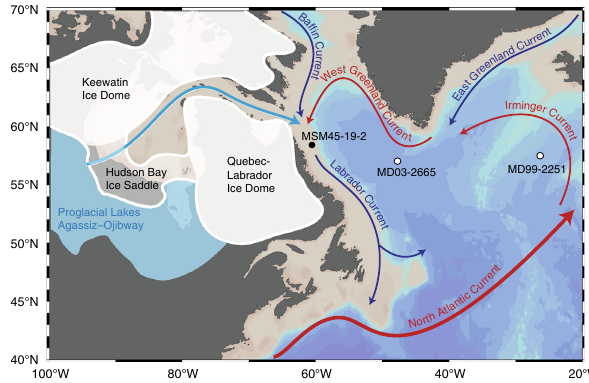
Fig. 1 North Atlantic Ocean circulation and sediment core locations. The white shaded area shows the extent of the Laurentide Ice Sheet (LIS) at 8.5 ka before present, with the Hudson Bay Ice Saddle connecting the Keewatin and Quebec-Labrador Ice Domes 32 – 34 . The blue shaded area displays Lake Agassiz-Ojibway that formed along the southern margin of the LIS and drained through subglacial channels in the Hudson Bay seabed (light blue arrow). Dark blue and red arrows represent cold and warm currents of the North Atlantic, respectively. The Labrador Current originates from a mixture of the cold, fresh Baf fi n Current and the warmer, more saline West Greenland Current, which is composed of Atlantic waters from the Irminger Current and the cold, fresh East Greenland Current. Core locations are marked with black (this study) and white (other studies)